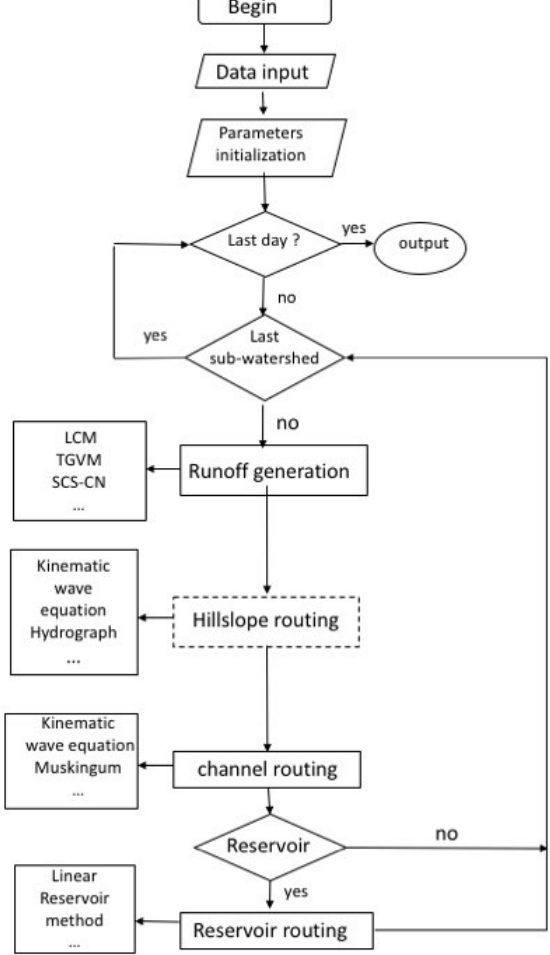
Figure 1. HIMS model customization.